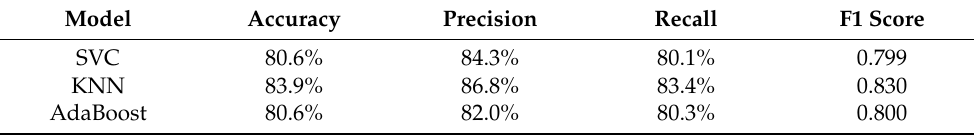
Table 18. Results for classification models when trained using the space and environment attributes.